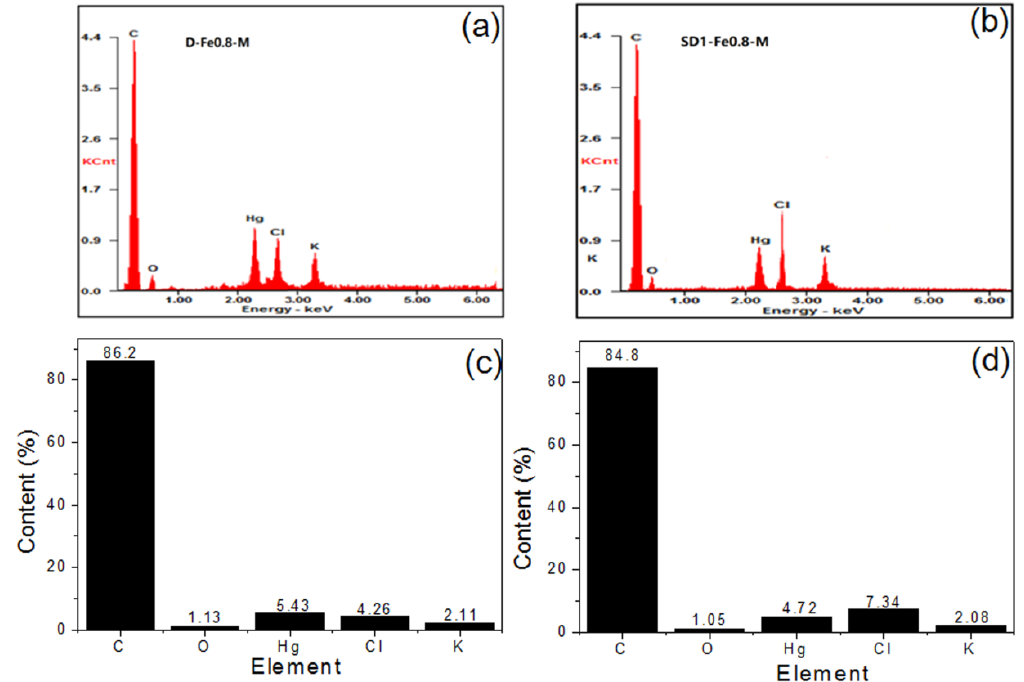
Figure 8. EDS of ( a ) active D-Fe0.8-M and ( b ) deactivated SD1-Fe0.8-M; element content derived from EDS of ( c ) active D-Fe0.8-M; and ( d ) deactivated SD1-Fe0.8-M